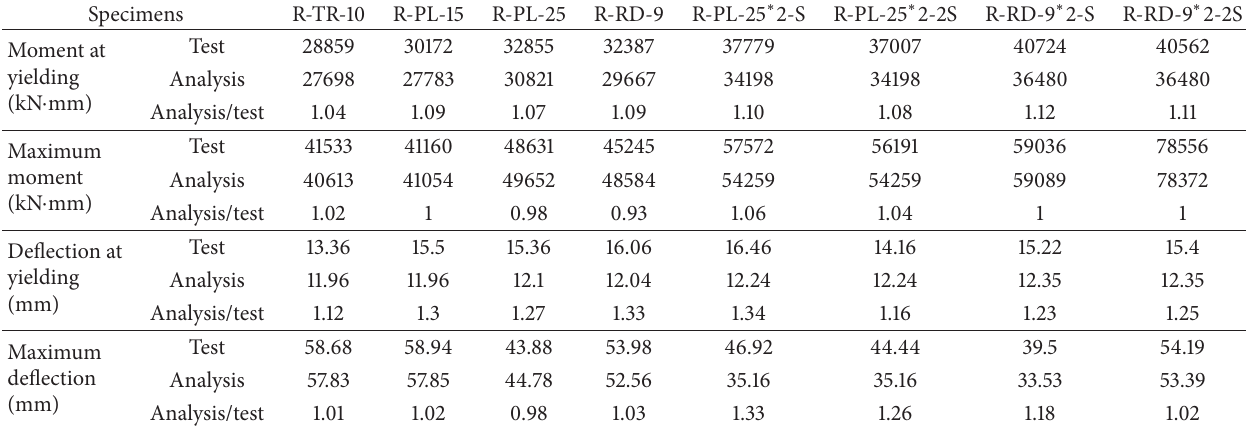
Table 4: Comparison of experimental and analytical